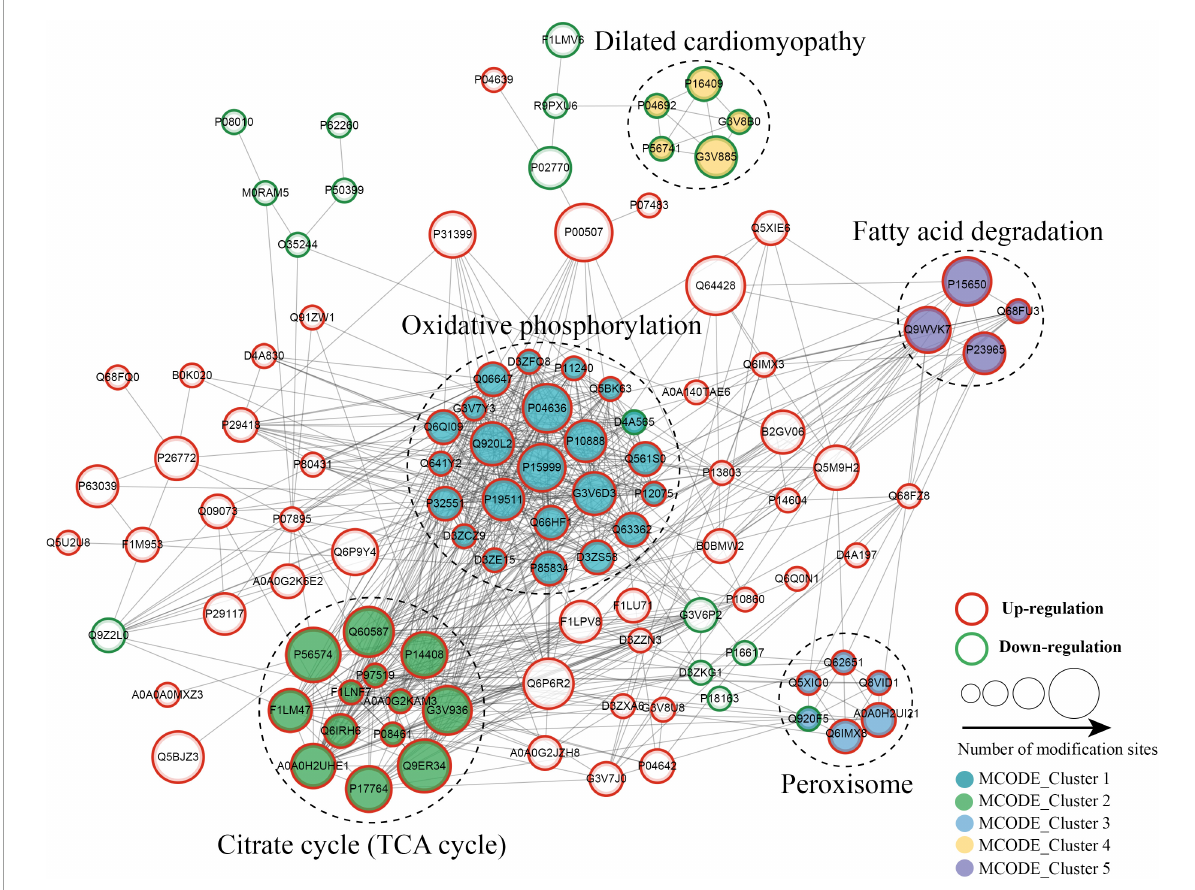
FIGURE7 Protein–protein interaction (PPI) networks of lysine β -hydroxybutyrylation (kbhb) proteins in heart tissue of diabetic cardiomyopathy (DCM)